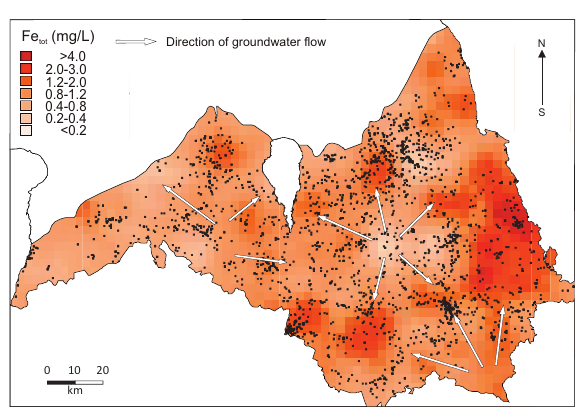
Fig. 2. Spatial distribution of Fe tot in the Middle Devonian aquifer system. The arrows indicate the approximate direction of groundwater flow in the aquifer system. The black dots mark the locations of sampled groundwater abstraction